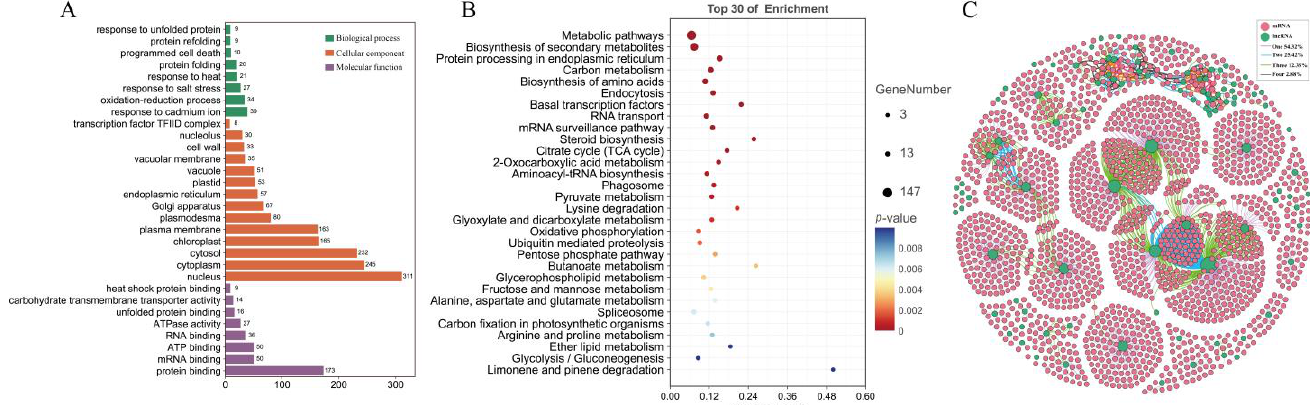
Figure 4. Interactions between DELs and their trans-regulated DEGs in M. glyptostroboides. ( A ) GO enrichment analysis of lncRNA trans-target genes. ( B ) KEGG pathway enrichment analysis of the trans-target gene. ( C ) Gephi network of differentially-expressed lncRNAs and co-expressed protein-coding genes: red circles represent lncRNAs and green circles represent protein-coding genes, with the size and complexity of the network reflecting the number of interactions involved.